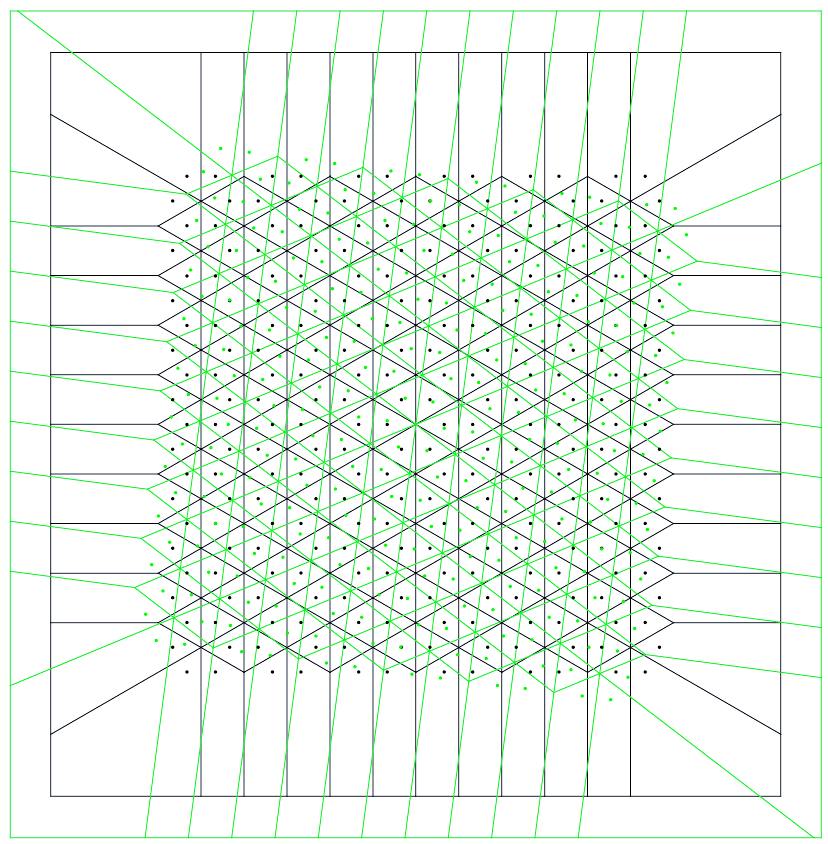
Figure 3. Two honeycomb structures rotated 7.47 ◦ in between are shown with black and green points, respectively; the Voronoi tessellation associated to each lattice is also displayed in green and black